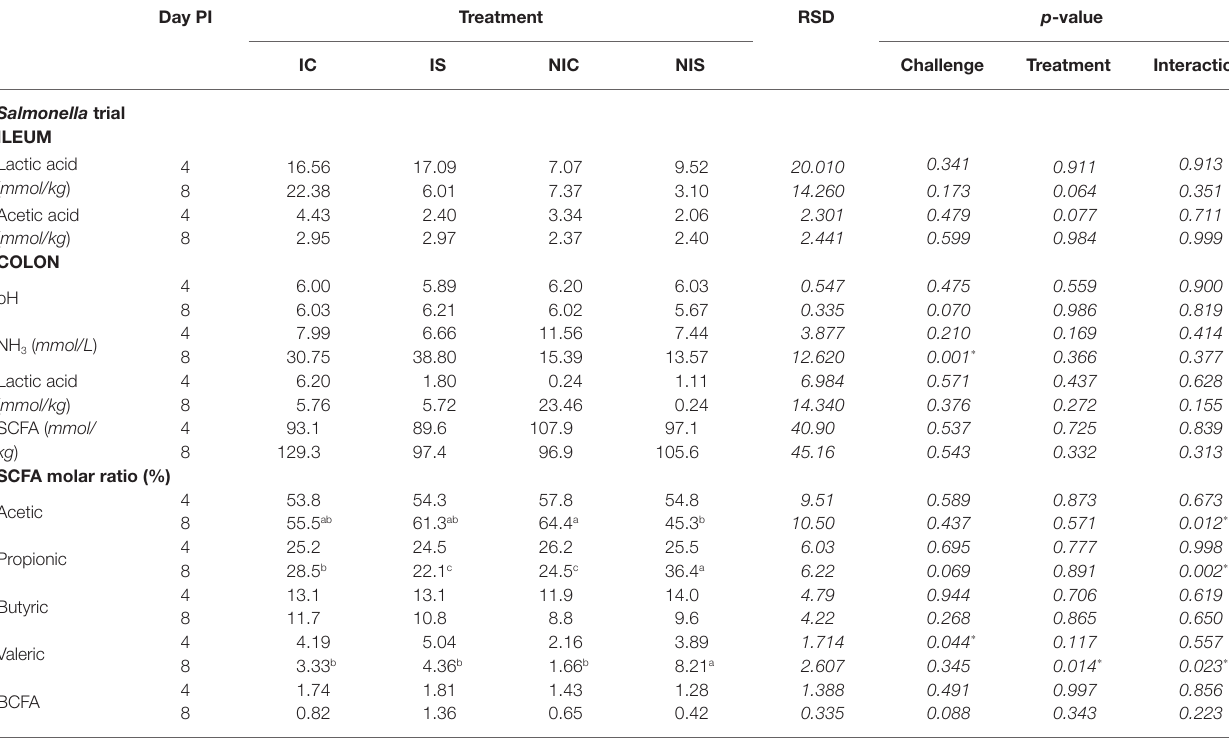
TABLE 4 | Effects of experimental treatments on ileal and colonic fermentation in the Salmonella trial. Day PI